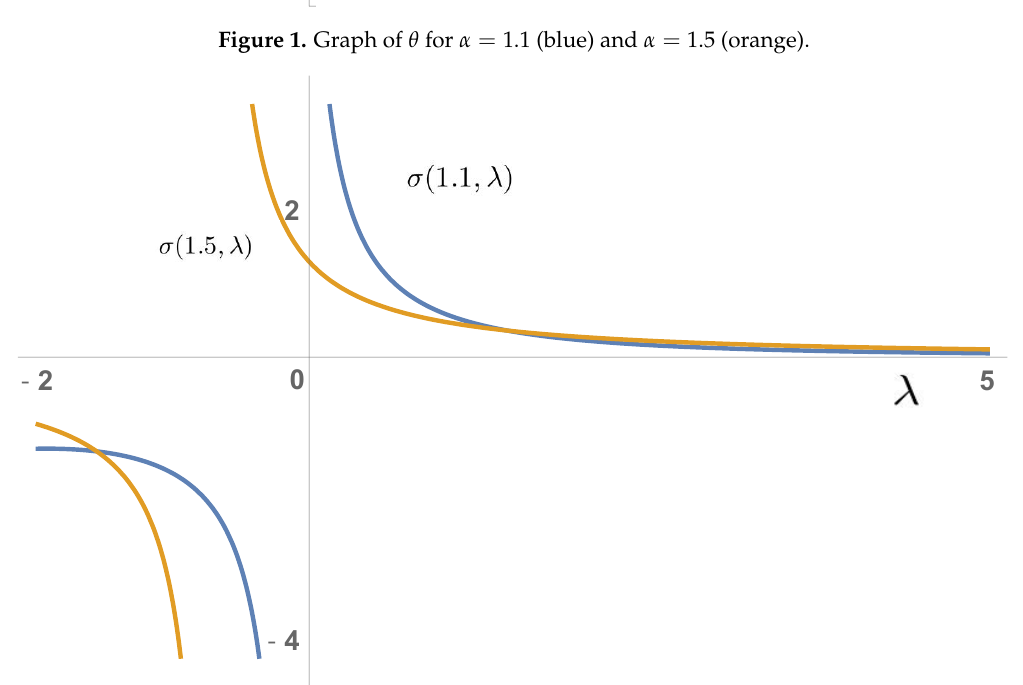
Figure 1. Graph of θ for α = 1.1 (blue) and α = 1.5 (orange).